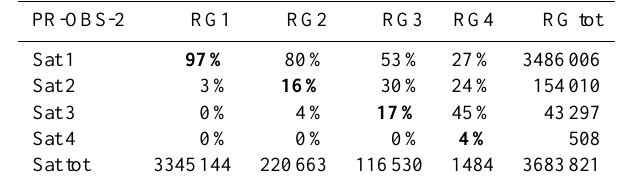
Table 10. Contingency table for the multi-categorical statistics for PR-OBS-1 as compared with rain gauge-derived rain fields.